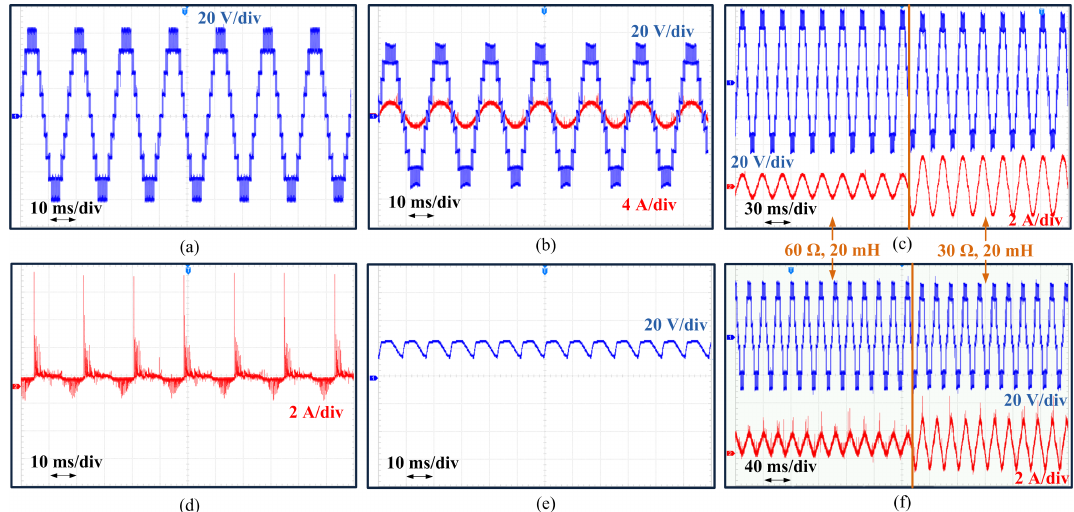
Figure 7. Experimental results of sine–triangle PWM applied to DB9LI: ( a ) No load voltage, ( b ) output voltage and load current at 60 Ω , 20 mH, ( c ) step load change at m a = 1, ( d ) capacitor current, ( e ) capacitor voltage, and ( f ) step load change at m a = 0.7.